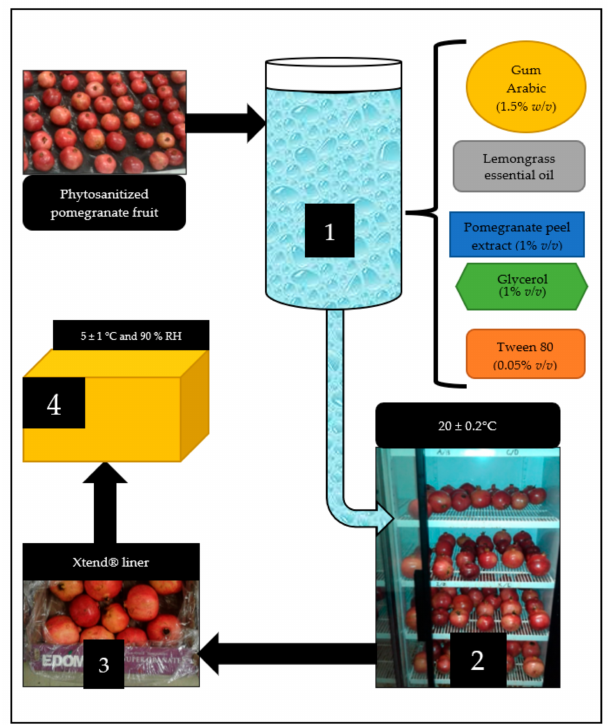
Figure 1. Flow diagram of the process of coating (1), drying (2), packaging (3) and cold storage (4) of phytosanitized ‘Wonderful’ pomegranate